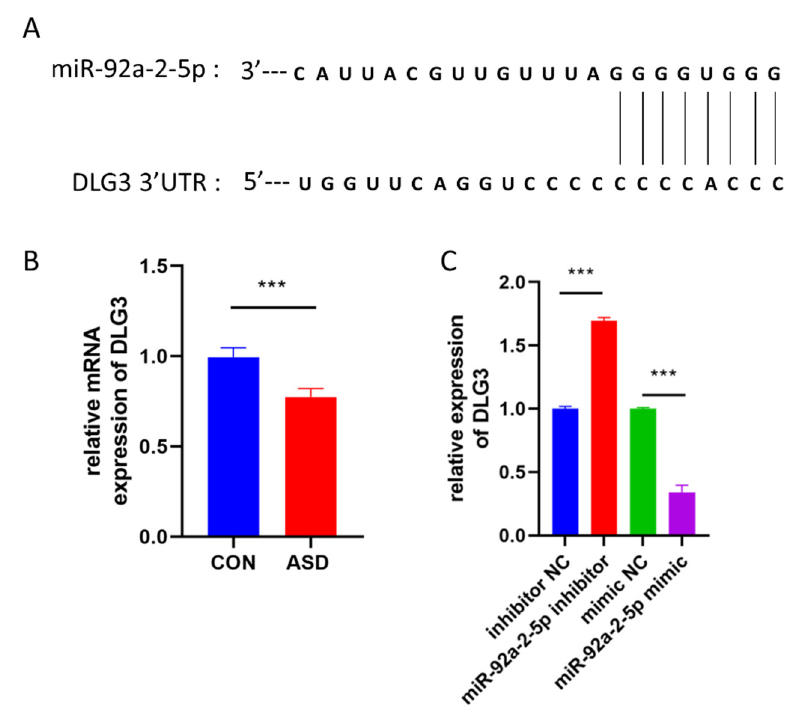
Figure 6. DLG3 might be a target gene of miR-92a-2-5p. ( A ) Putative target sites for miR-92a-2-5p in the 3 ′ UTR of DLG3. ( B ) Relative mRNA expression of DLG3 in CON and ASD-NPCs, as determined by RT-qPCR. ( C ) Relative mRNA expression of DLG3 after transfection with miR-92a-2-5p inhibitor, mimic, and negative control in NPCs. All data represent mean ± SEM; *** p < 0.001.